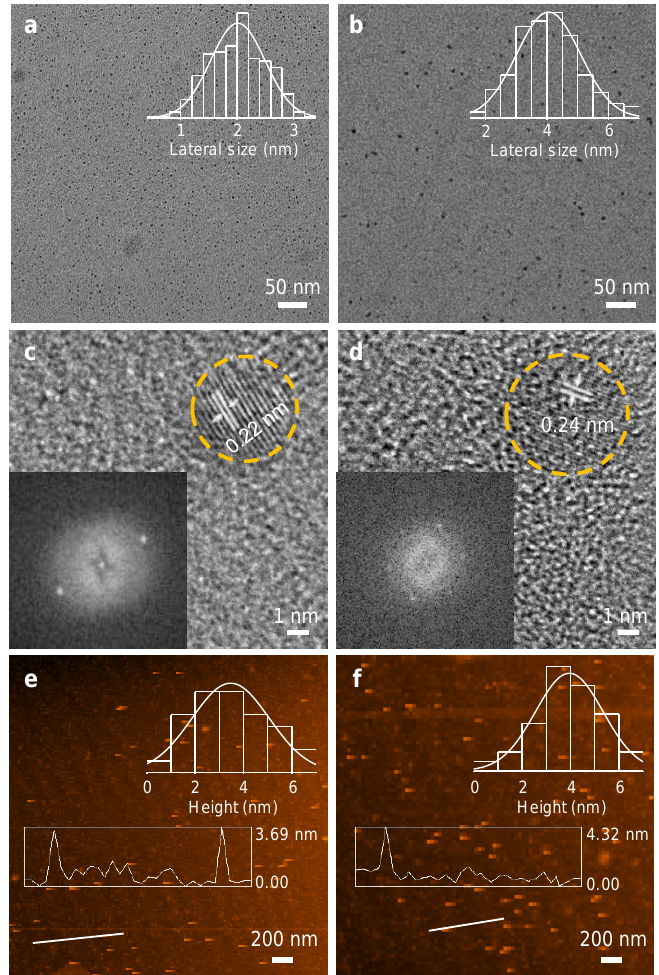
Figure 1. The TEM images and relative size distribution of GQDs ( a ) and Cl-GQDs ( b ). The high- resolution TEM images of GQDs ( c ) and Cl-GQDs ( d ) (insets: fast Fourier transform pattern). AFM images and height distributions of GQDs ( e ) and Cl-GQDs ( f ).